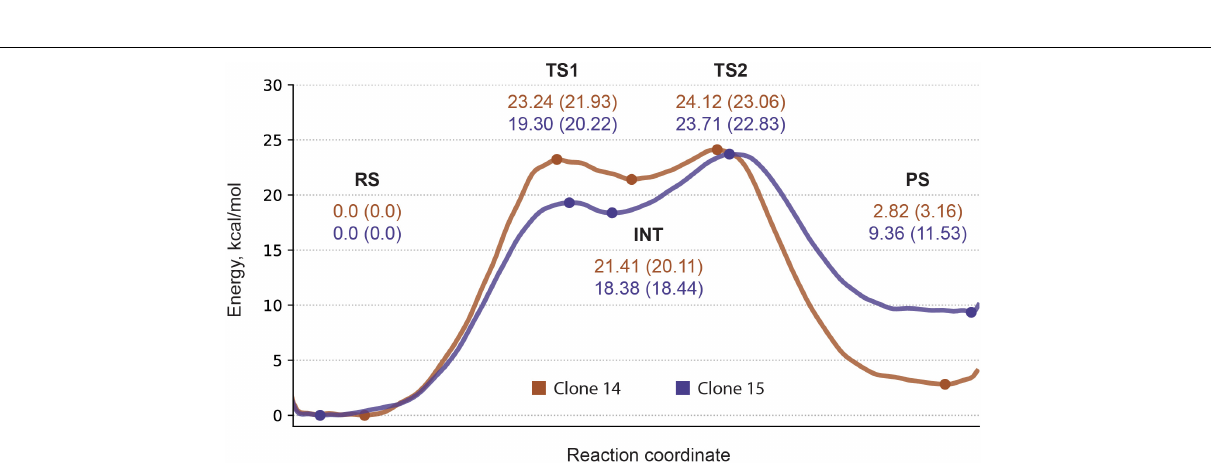
Frontiers in Pharmacology |